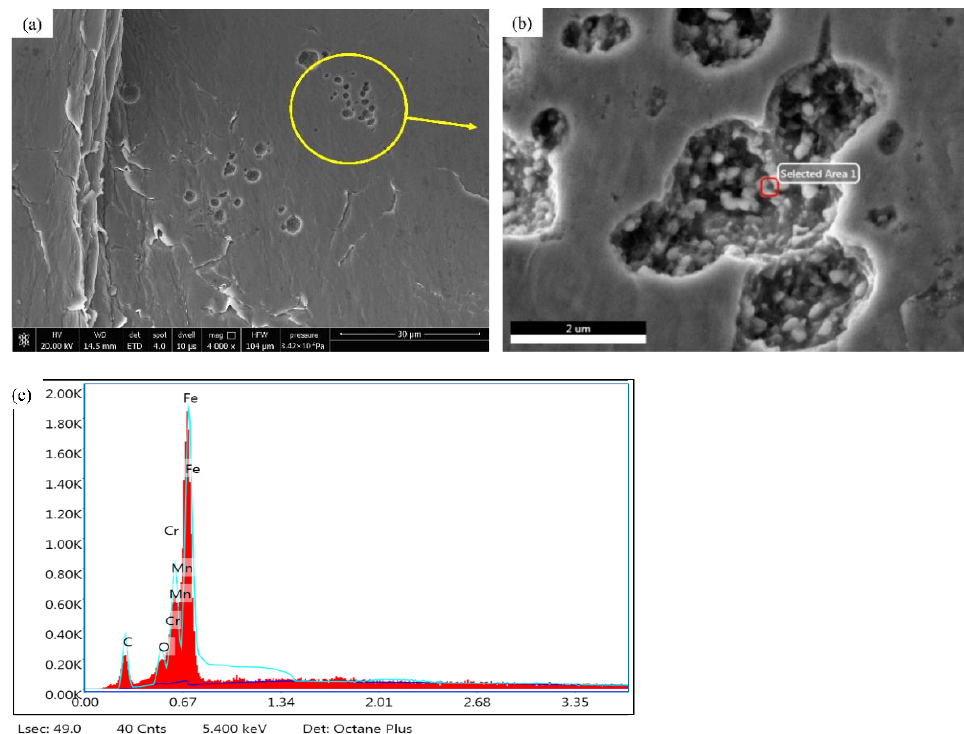
Figure 10. ( a ) Surface pitting diagram; ( b ) enlarged view of pitting pit; ( c ) composition analysis of oil sludge in pitting pit.